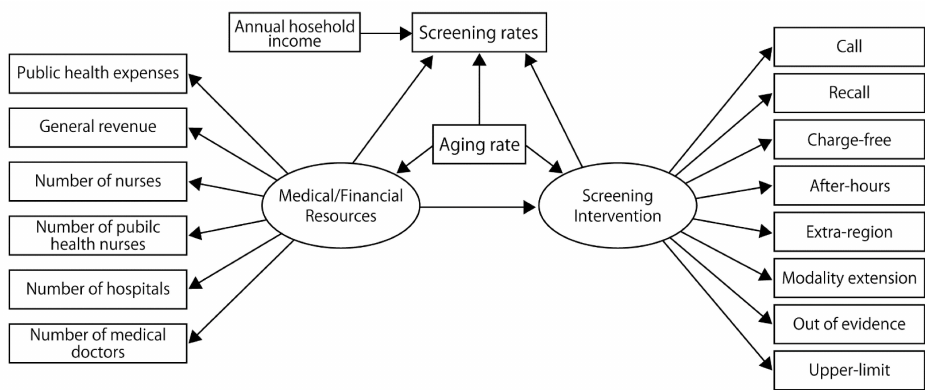
Figure 1. A pre-analysis model built on the initial hypothesis. Call, screening invitations to the residents; Recall, re-invitations to those unscreened after the call; Modality extension, providing cancer screening using a modality outside the recommendation of the national guideline; Out of evidence, providing screening with little evidence of mortality reduction; Upper limit set, limiting the number of people who can participate in the cancer screenings; Extra-region, providing an opportunity for the residents to take screening in other municipalities; After-hours, providing screenings on holidays or in the evenings; charge-free, providing cancer screenings free of